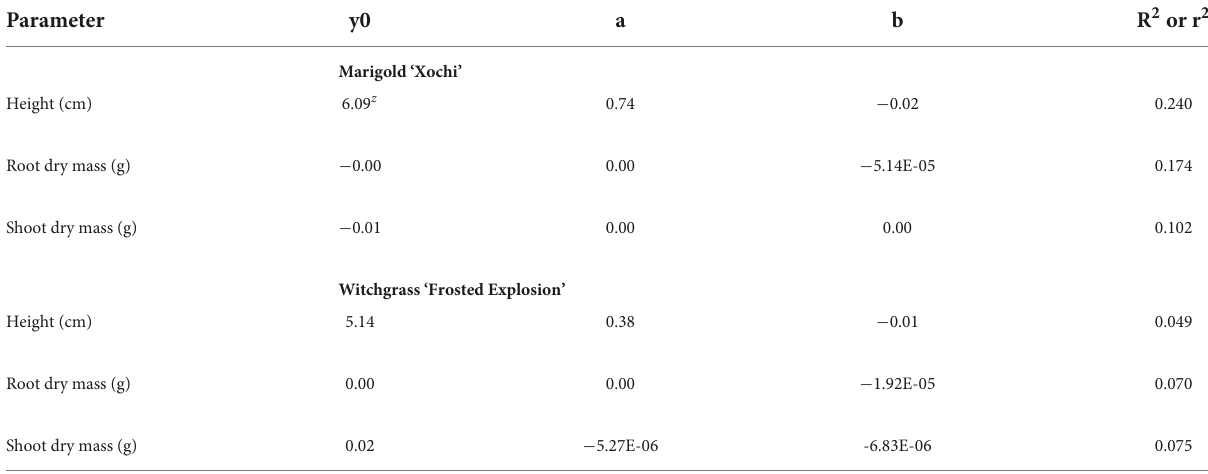
TABLE 7 Regression analysis equations and r 2 or R 2 for height, root dry mass, and shoot dry mass in response to photoperiod (P; 9-, 11-, 12-, 13-, 14-, 15-, 16-, 18-, 24-h photoperiods or a 4-h NI) of marigold ‘Xochi’ ( Tagetes erecta ) or witchgrass ‘Frosted Explosion’ ( Panicum capillare